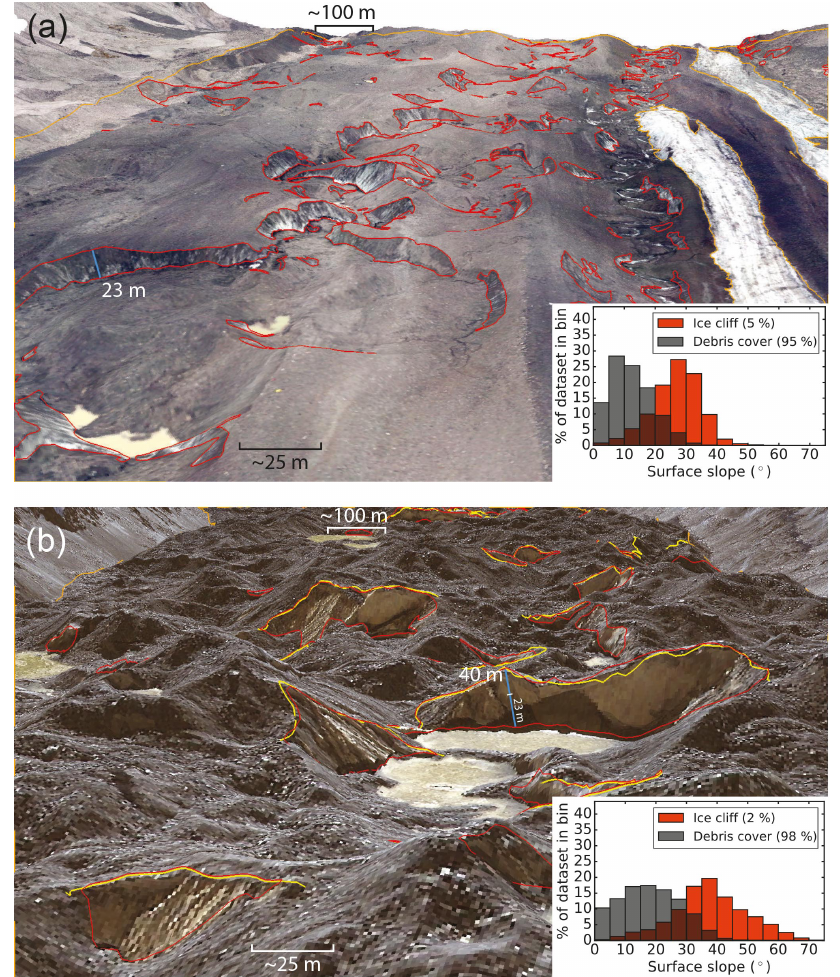
Figure 3. (a) Portion of Canwell Glacier, Alaska, USA, looking down glacier a distance of ∼ 1.4km. Manually generated debris-covered area outlines and ice cliff outlines are shown in orange and red, respectively. The underlying image is an orthomosaic of visible imagery collected above Canwell Glacier on 29 July 2016, draped over a DEM derived from the same images. The inset histogram shows normalized populations of surface slopes present in the pictured debris-covered area and ice cliff area; the grey/orange region of overlap illustrates the difficulty of using surface slope alone to identify ice cliffs. Percentages give the fraction of the total area occupied by both classes (in map view). (b) Same as panel (a) but for Ngozumpa Glacier, Nepal, also looking down glacier a distance of ∼ 1.4km. The scale in panels (a) and (b) are the same. Yellow lines are ice cliff top edges mapped by Thompson et al. (2016) which were manually expanded to ice cliff area (red) with minor additions. The underlying image and DEM are from GeoEye-1 acquired on 23 December 2012 (Sect. 2.2.2). Locations shown